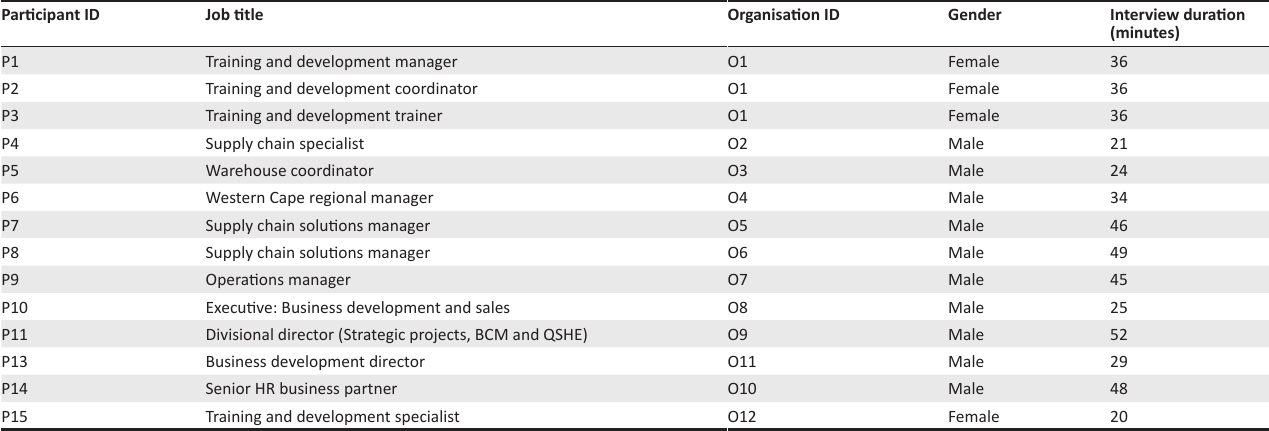
TABLE 4: Profiles of the